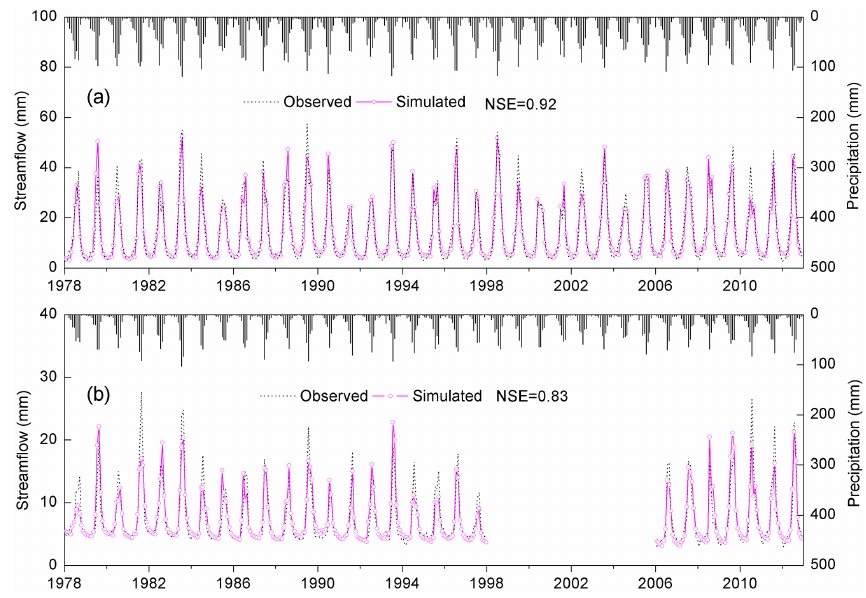
Figure 4. Time series of observed and simulated monthly streamflow using the abcd model in region I (a) and region II (b) during